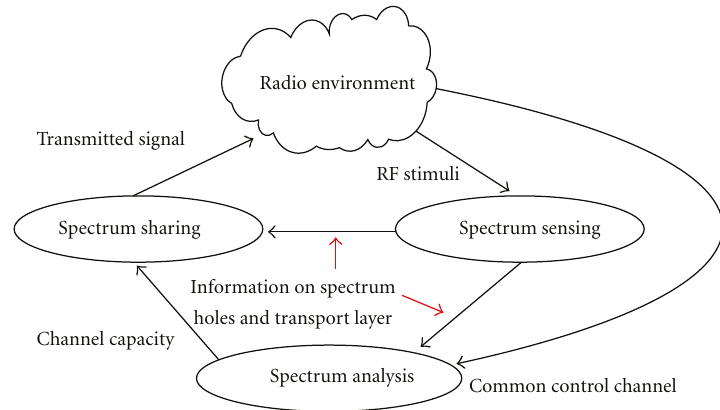
Figure 2: Cognitive cycle in TACS.